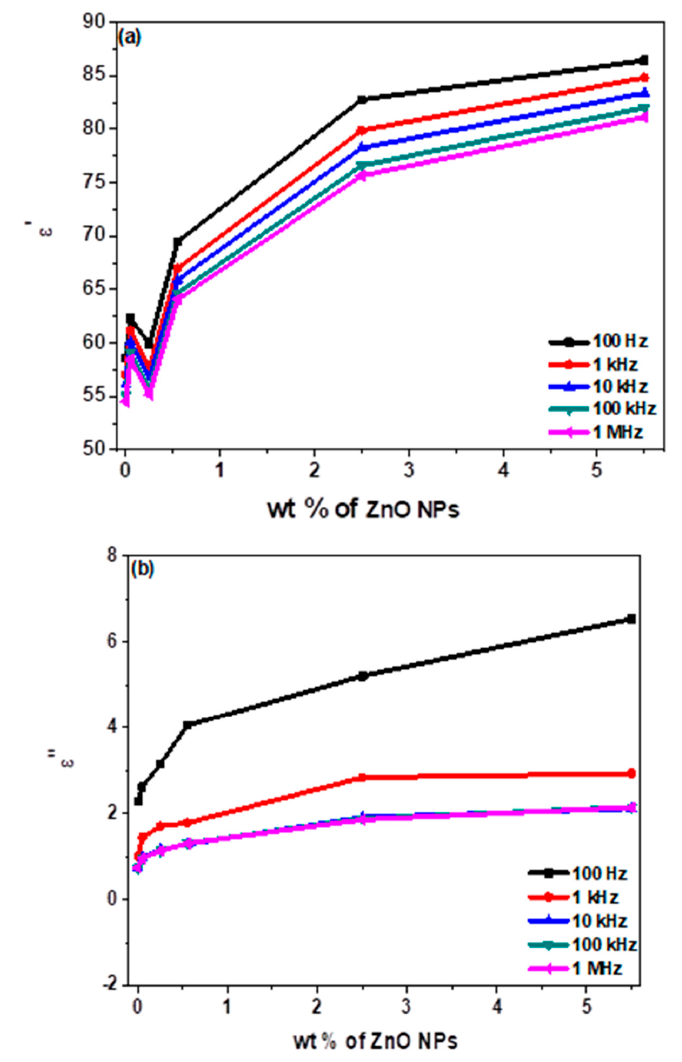
Figure 10. ( a , b ): Dependence of ( a ) ε′ , and ( b ) ε″ values on wt% of ZnO nanofiller at 30 °C.